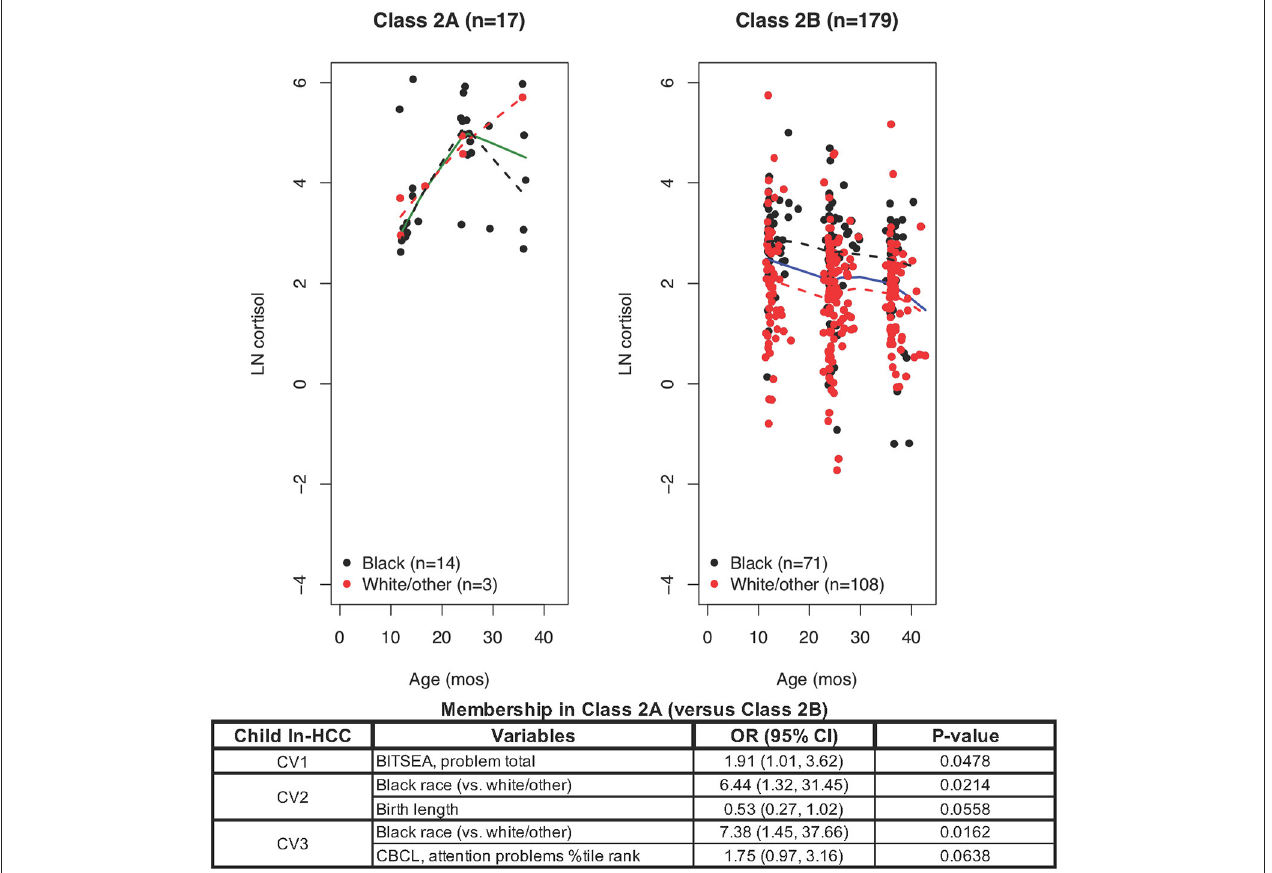
FIGURE 2 | LCMM model only for Class 2 members revealed Class 2A and Class 2B: ln-HCC values plotted by age in months, with solid regression lines for all children, dashed regression lines for Blacks (black) and White/other races (red). Logistic regression showed that Class 2A membership was associated with Black race (CV2, CV3) and greater social-emotional problems (CV1), with trends for shorter body length at birth (CV2) and greater attention problems at CV3.